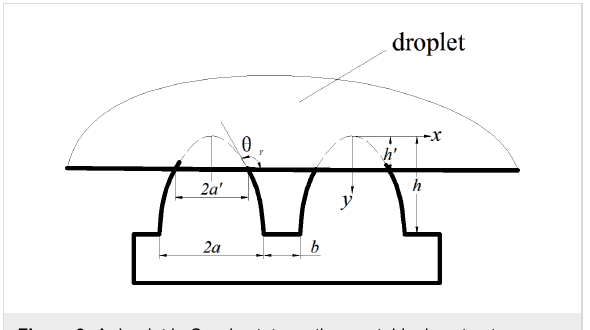
Figure 9: A droplet in Cassie state on the mastoid microstructure surface.